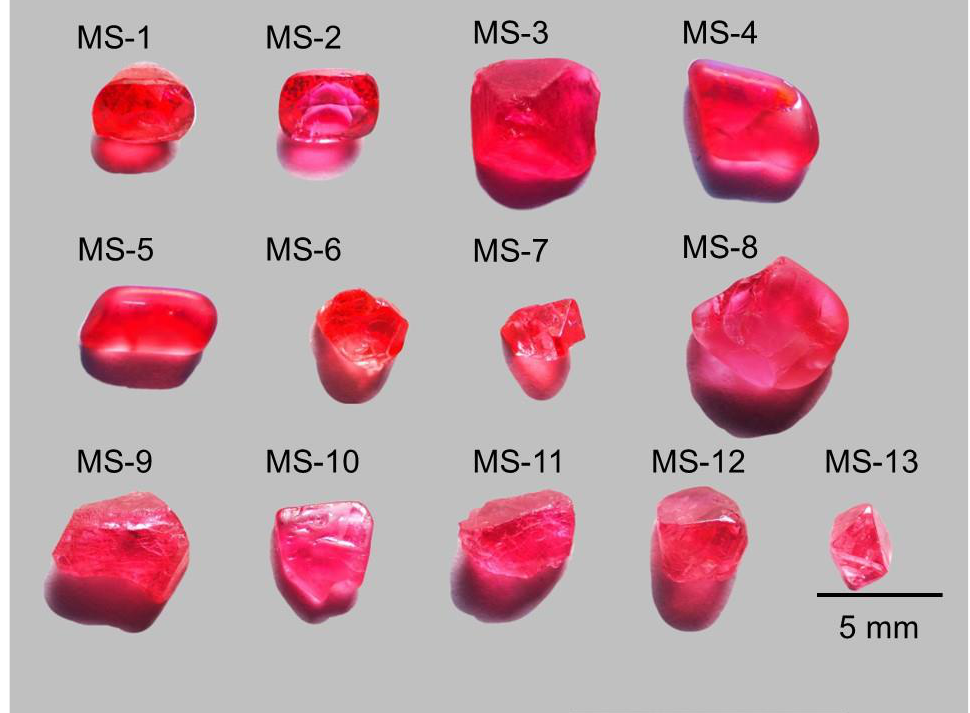
Figure 2. The spinel samples from Man Sin: Faceted finish stones MS-1, MS-2, rough stones MS-3, MS-4, MS-5, MS-6, MS-7, MS-8, MS-9, MS-10, MS-11, MS-12, MS-13 .